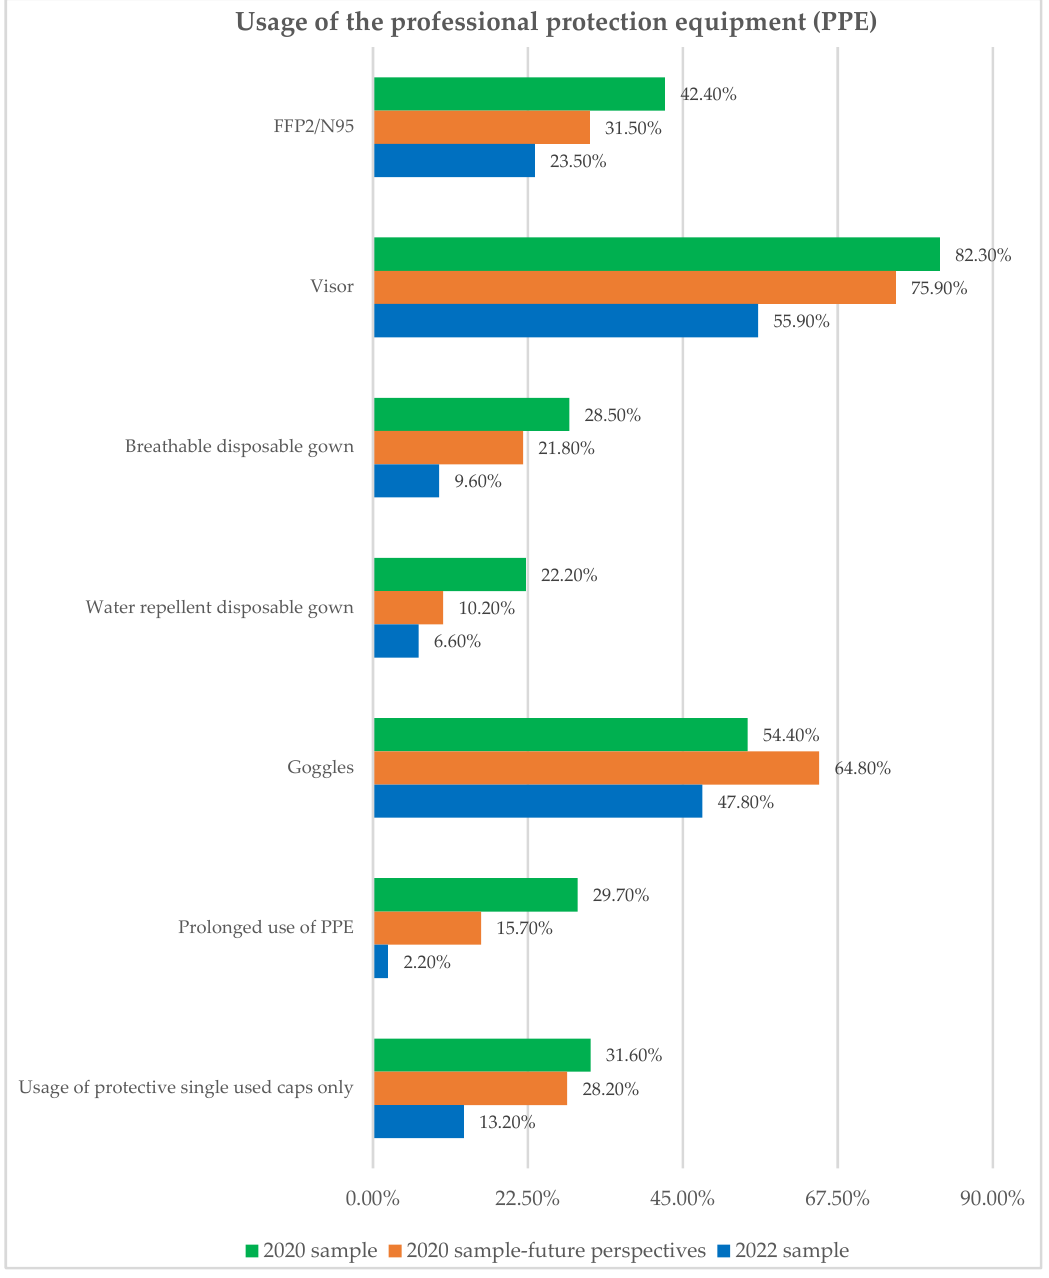
Figure 3. Usage of various PPE forms in study participants which mostly differed. Table 6. Differences in the usage of PPE within the 2020 sample and between the 2020 and 2022